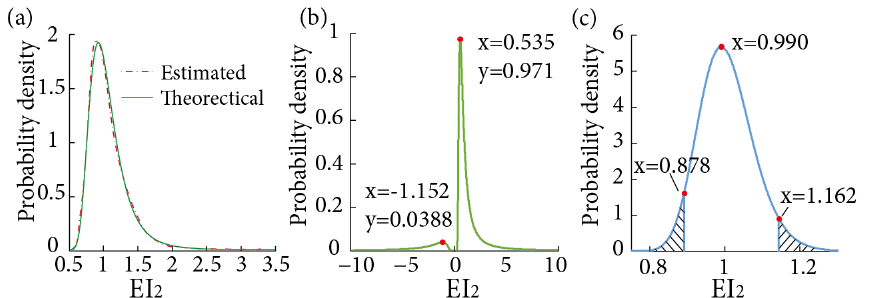
Figure 4. Probability density curves for the estimations of EI 2 using ( a ) set 1 ( v 5 , v 7 and v 9 ) with 5% error (theoretical distribution and inferred from data), ( b ) set 1 ( v 5 , v 7 and v 9 ) with 20% measurement error and ( c ) set 3 ( w 5 , w 9 ) with 20% measurement error (shaded area for 2.5% and 97.5% percentiles). (KDE for kernel density estimation.)